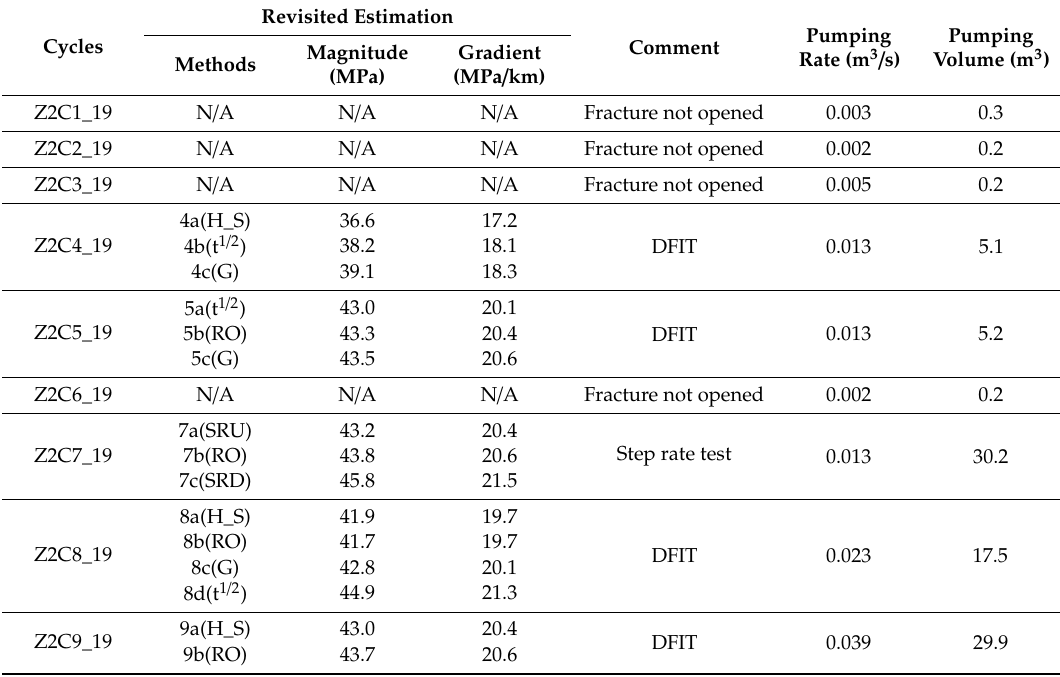
Table A3. Closure pressure measurements of Zone 2 (TVD 2122